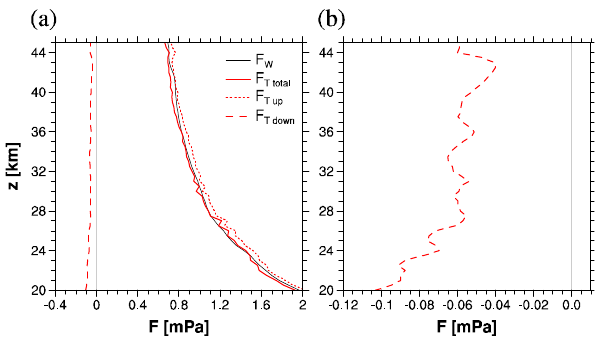
Fig. 4. (a) Momentum-flux profiles estimated from temperature variances by upward (red, dotted) and downward waves (red, dashed) for eastward propagating waves, and the sum of the two (red, solid). The momentum-flux profile calculated from wind perturbations for eastward propagating waves is also plotted (black, solid). The momentum-flux profile from temperature variances by downward waves is plotted again with an enlarged scale in (b).